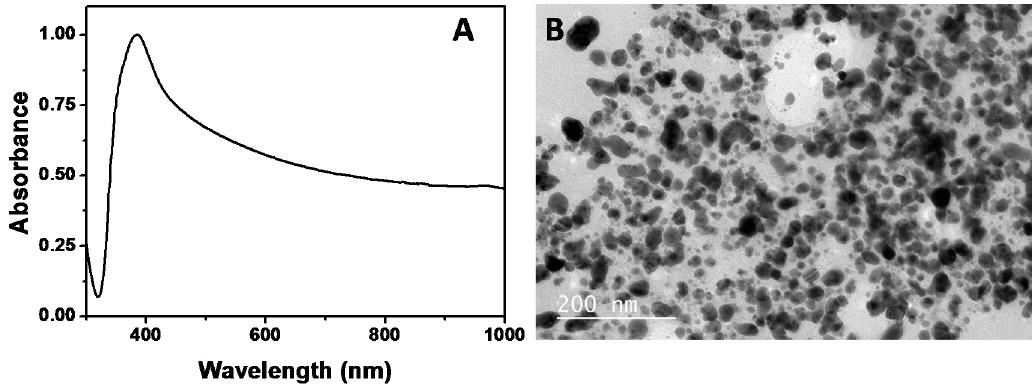
Figure 4. ( A ) Normalized UV-Vis-NIR spectrum of biosurfactant stabilized Ag NPs obtained by the reduction of silver nitrate at 60 °C; ( B ) Representative TEM image of the BS-Ag NPs.